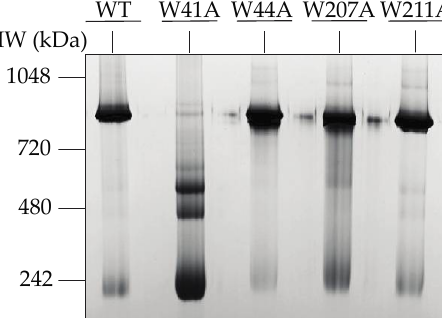
Figure 4. Oligomeric state of in vitro assembled PC portal rings. ( a ) Mass spectra of WT and variant PC portal rings measured by CDMS. The mass (in kDa) of each major peak is shown to the right. The expected mass of monomer portal protein is ~82.7 kDa for 11-mer is 910 kDa and for 12-mer is 993 kDa. ( b ) Native gel electrophoresis of WT or variant PC rings using native PAGE 4–16% bis-tris protein gel.